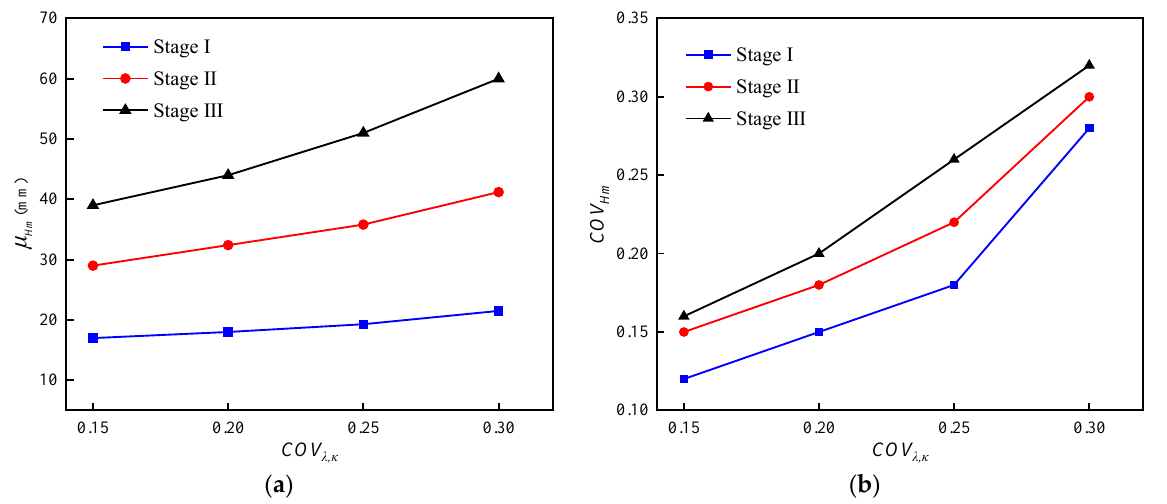
Figure 17. Effect of COV λ , κ on the ground surface settlement at various construction stages: ( a ) mean of H m ; ( b ) COV of H m .